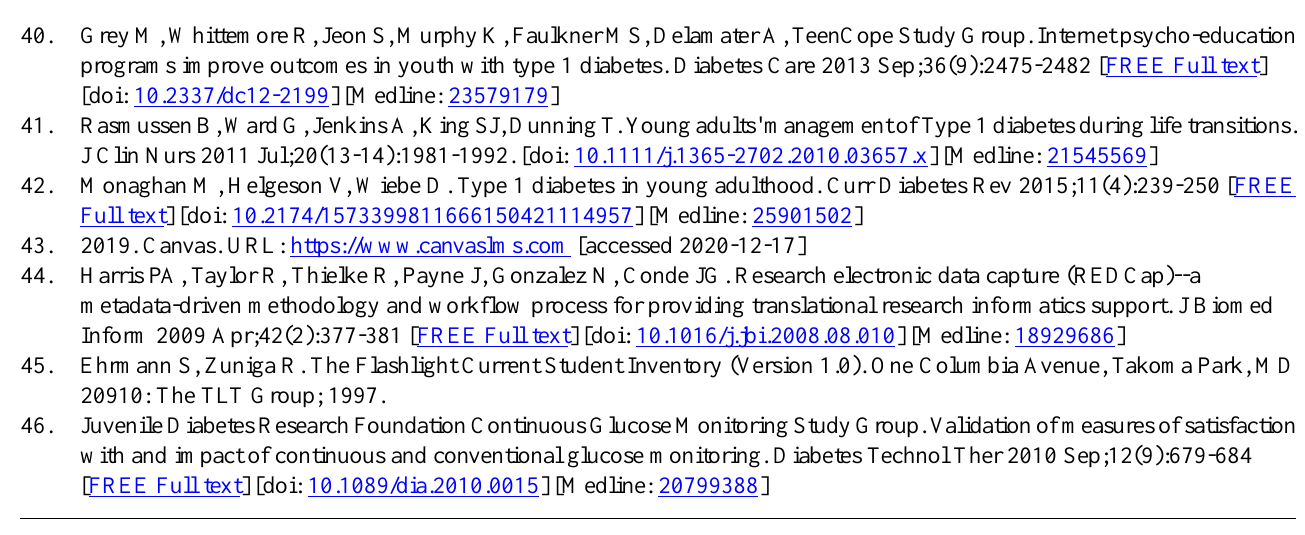
Abbreviations CGM: continuous glucose monitor IDEAL: Intervention Designed to Educate and Improve Adherence Through Learning HbA : hemoglobin A 1c 1c REDCap: Research Electronic Data Capture T1D: type 1